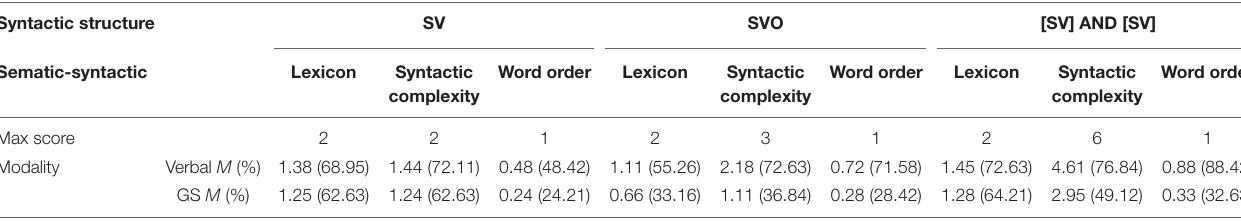
TABLE 3 | Sematic-syntactic scores across syntactic structure and modalities. Syntactic structure